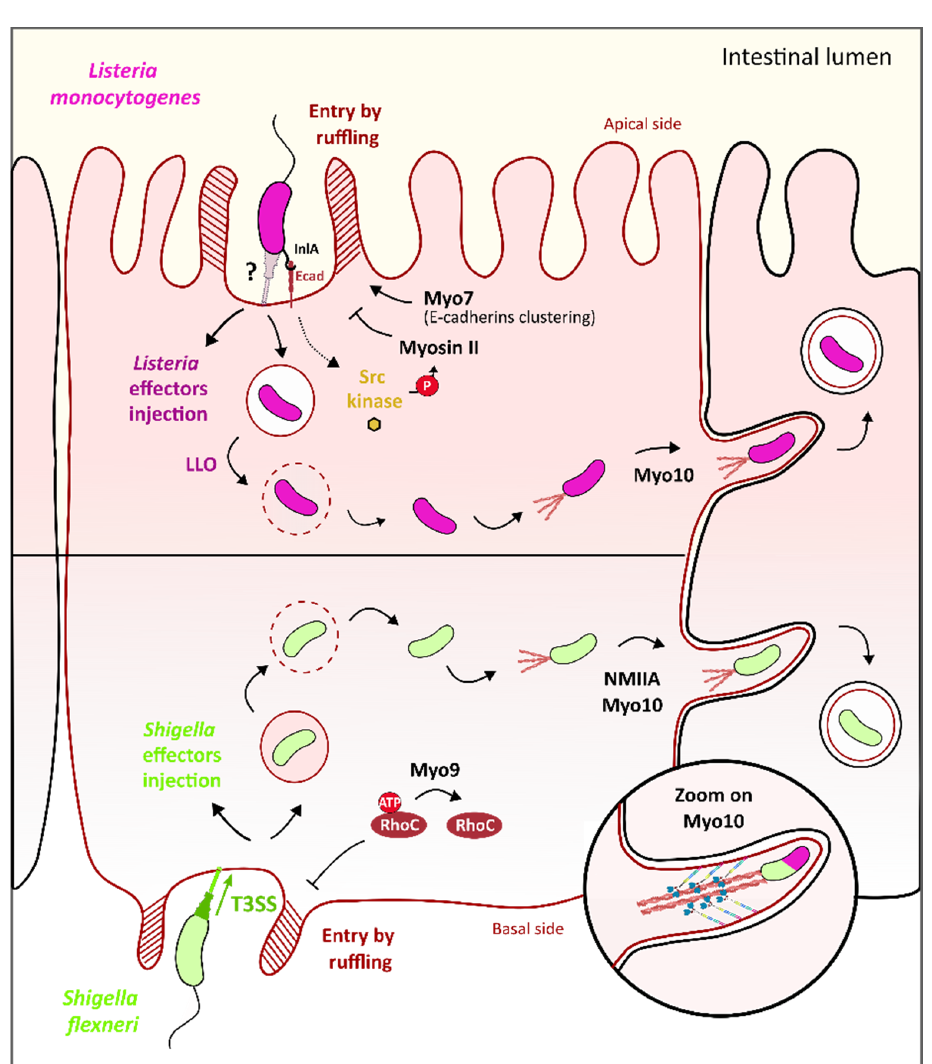
Figure 5. Role of Myosin IIA/VII/IX/X in L. monocytogenes and S. flexneri cell invasion and cell-to-cell spreading. S. flexneri (in light green, lower panel) entry on the basal side of epithelial cells by membrane ruffling is regulated by myosin IX. Specifically, Myo9b RhoGAP domain triggers the inactivation of RhoC, a Rho GTPase that activates actin polymerization, to stop protrusion formation/extension. Upon entering, Shigella is released into the cell cytosol and triggers the formation of an actin structure called “actin tail” at one pole to acquire actin-based intra- and intercell motility. Myosin X, as well as myosin IIa, promotes this step. Specifically, myosin X binds the membrane through its four-point-one, ezrin, radixin, moesin (FERM) domain and actin through its head domain. The motor domain activity is used as a strength to form the protrusion and “push” bacteria toward the neighboring cell. L. monocytogenes (in purple, upper panel) entry at the apical side of epithelial cells is induced by injection of bacterial effectors (in dark purple) inside the host cell cytoplasm that trigger actin polymerization and subsequent membrane ruffling. Entry of L. monocytogenes is facilitated by myosin VII/vezatin/cell adhesion complex pathway, which stabilizes membrane protrusions at the entry site of the bacteria. Conversely, membrane ruffling is balanced by myosin II to ensure the optimal enclosure of the bacteria inside the intracellular vacuole. Bacterial listeriolysin O (LLO) toxin lyses the vacuolar membrane, thus releasing L. monocytogenes in the cell cytosol. Here, bacteria promote the polymerization of actin at one of its poles, in an actin tail structure, which makes bacteria motile in order to escape cytosolic defenses such as autophagy and to spread to nearby cells. Similar to S. flexneri , myosin X plays a key role in this cell-to-cell spreading